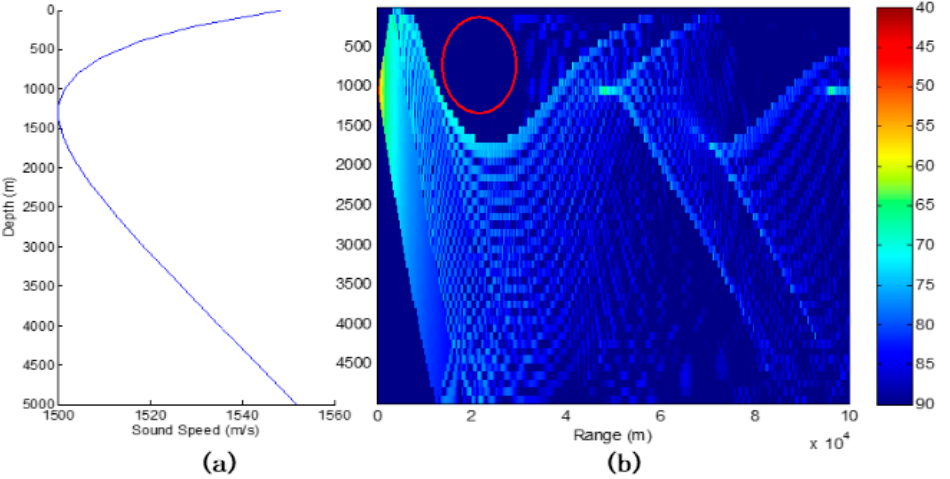
Figure 3. Example of sound acoustic zone: ( a ) the speed of sound; ( b ) the transmission loss, where the red circle is an acoustic shadow zone.